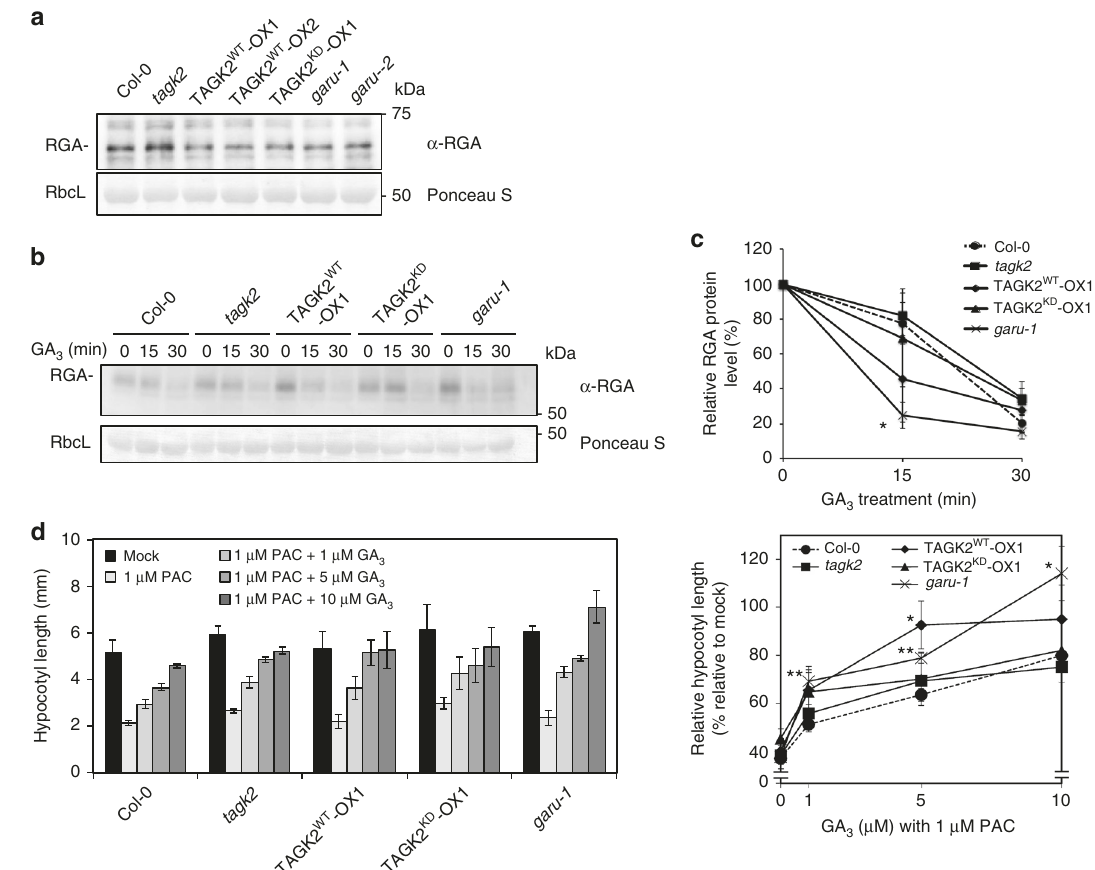
Fig. 6 GARU and TAGK2 mediate sensitivity of GA response in the plant. a Immunoblot analysis of GID1A/C in Col-0, tagk2 , TAGK2 WT -OX1, TAGK2 WT - OX2, TAGK2 KD -OX1, and garu-1 . b , c GA-induced RGA degradation assay in Col-0, tagk2 , TAGK2 WT -OX1, TAGK2 KD -OX1, and garu-1 seedlings. Seedlings were treated with 5 µ M GA 3 at indicated times, and RGA proteins was detected by immunoblot analysis with anti-RGA antibody ( b ). Signal value of RGA proteins and RbcL were measured by ImageJ software. RGA protein levels were normalized to RbcL, and the value of the starting point was set to 100% ( c ). Data are means ( ± s.d.) of three independent experiments ( n = 3). Statistically signi fi cant changes compared with in the starting point are indicated ( *P < 0.05, as determined using two-tailed Student ’ s t -test). d Hypocotyl elongation assay of etiolated seedlings of Col-0, tagk2 , TAGK2 WT -OX1, TAGK2 KD -OX1, and garu-1 in the presence or absence of GA 3 and PAC. Hypocotyl length was measured using ImageJ software (left). Relative hypocotyl length was calculated as the ratio of the mock treatment (right). Error bars indicate ± s.d. of three replicates, n = 24. Statistically signi fi cant changes compared with Col-0 are indicated ( *P < 0.05, **P < 0.01, as determined using two-tailed Student ’ s t